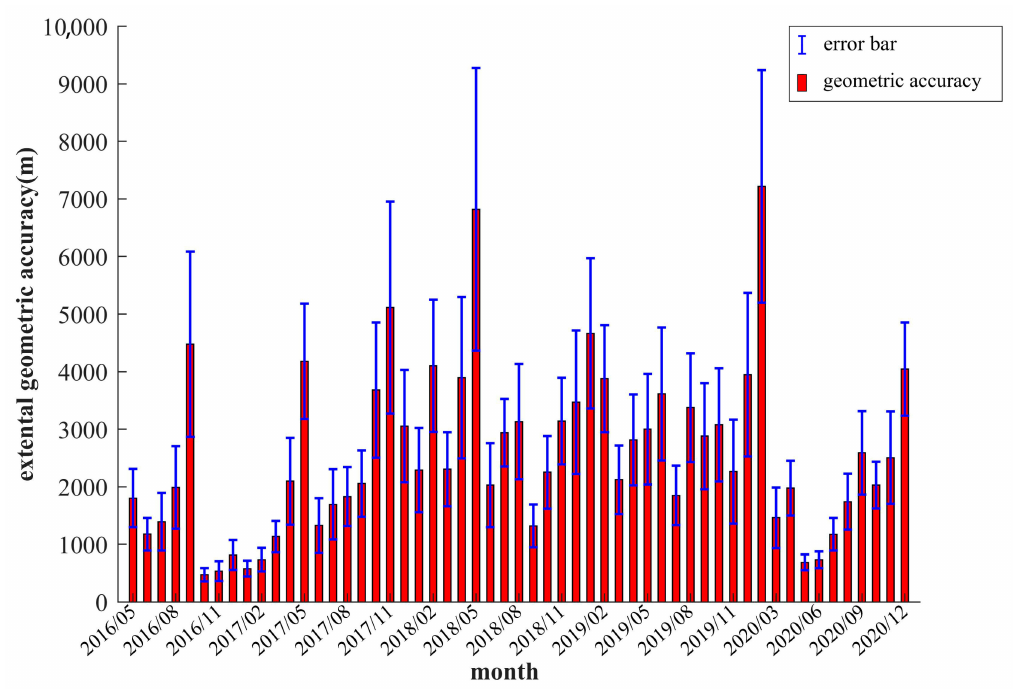
Figure 6. Variation of the external geometric accuracy with